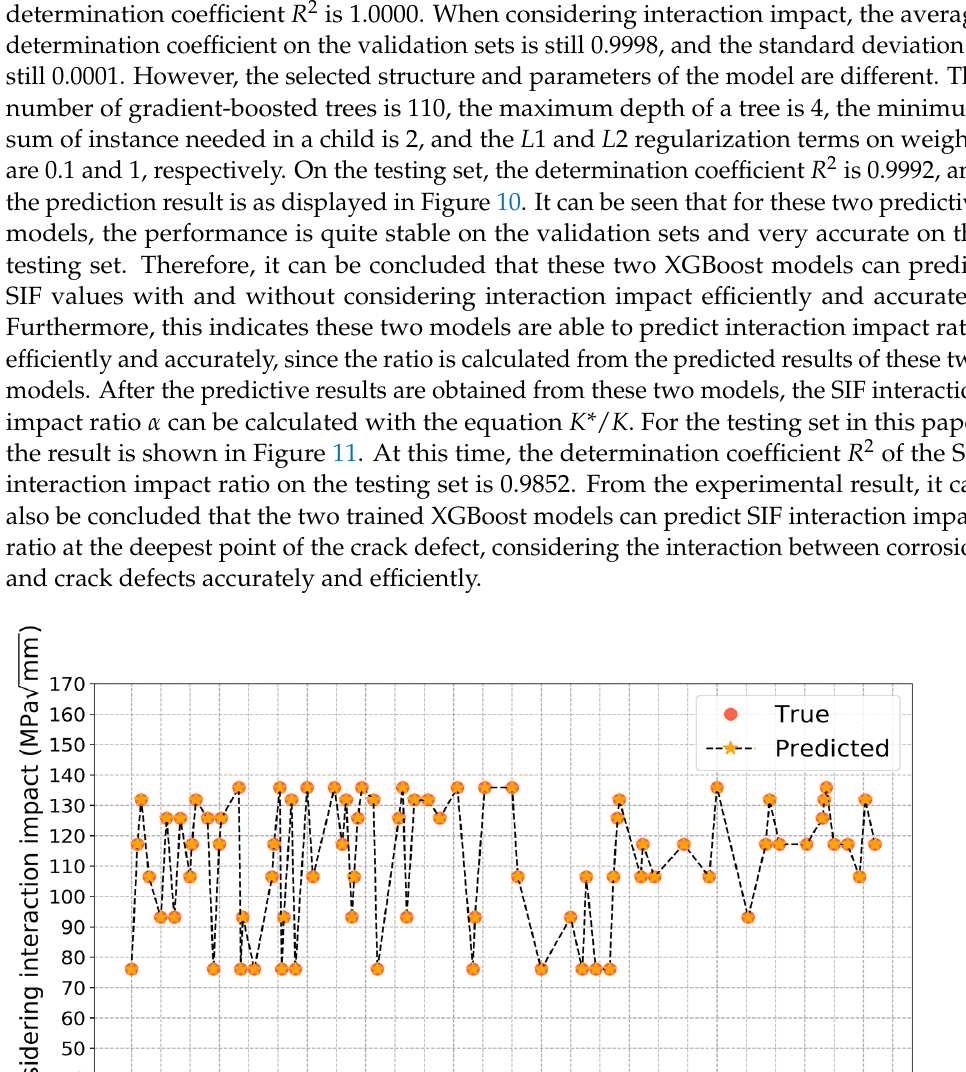
Figure 10. Prediction results of SIF values considering interaction impact based on approach 2.